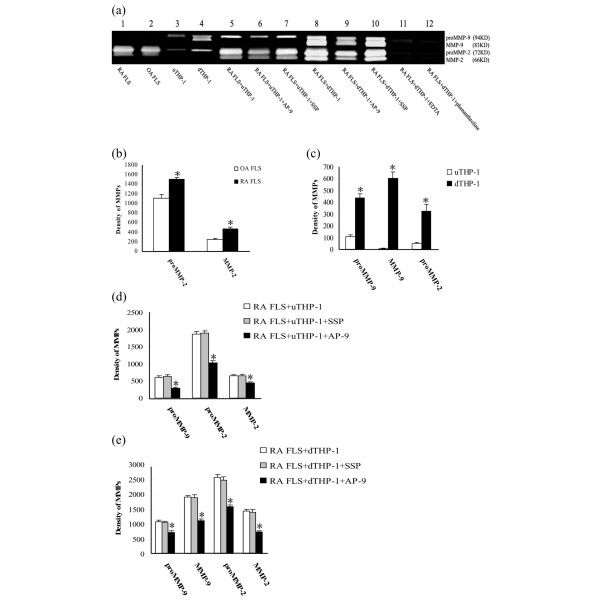
Gelatin zymography of culture medium conditioned by fibroblast-like synoviocytes (FLS) and THP-1 cells. Cells were cultured in serum-free media for 24 hours, and the conditioned media were collected and analyzed for matrix metalloproteinase (MMP) activity by gelatin zymography. (a) Secretion and activation of MMPs in FLS from rheumatoid arthritis (RA) and osteoarthritis (OA) patients, THP-1 cells, RA FLS co-cultured with THP-1 cells and in co-cultured cells treated by AP-9 or SSP, and ethylenediamine tetraacetic acid or phenanthroline. Top two bands, MMP-9 gelatinase; lower two bands, MMP-2 gelatinase. (b) The value of proMMP-2 and MMP-2 activity of RA FLS was higher than that of OA FLS (six samples with RA FLS, four samples with OA FLS; P < 0.05). (c) The value of proMMP-9, MMP-9 and proMMP-2 activity of differentiated THP-1 cells (dTHP-1) was higher than that of undifferentiated THP-1 cells (uTHP-1) (n = 6, P < 0.05). (d) The value of proMMP-9, MMP-9 and proMMP-2 activity of RA FLS co-cultured with uTHP-1 was higher than that of co-cultured cells treated by AP-9 (n = 6, P < 0.05), while no inhibitory effects were found in irrelevant peptide SSP (n = 6, P > 0.05). (e) The value of proMMP-9, MMP-9, proMMP-2 and MMP-2 activity of RA FLS co-cultured with dTHP-1 was higher than that of co-cultured cells treated by AP-9 (n = 6, P < 0.05), while no inhibitory effects were found in irrelevant peptide SSP (n = 6, P > 0.05). Values are the means ± standard error (n = 4–6). *P < 0.05 (experimental groups versus control groups).